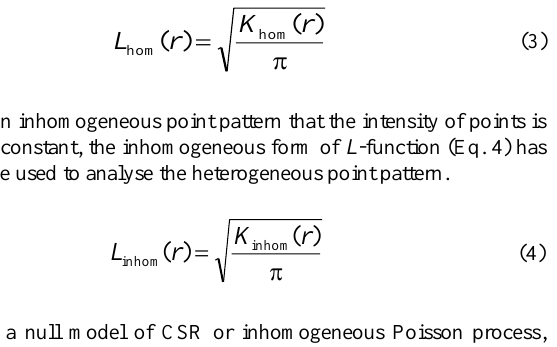
Figure 4. Map showing the pattern of wild pistachio trees (n=431) in the study